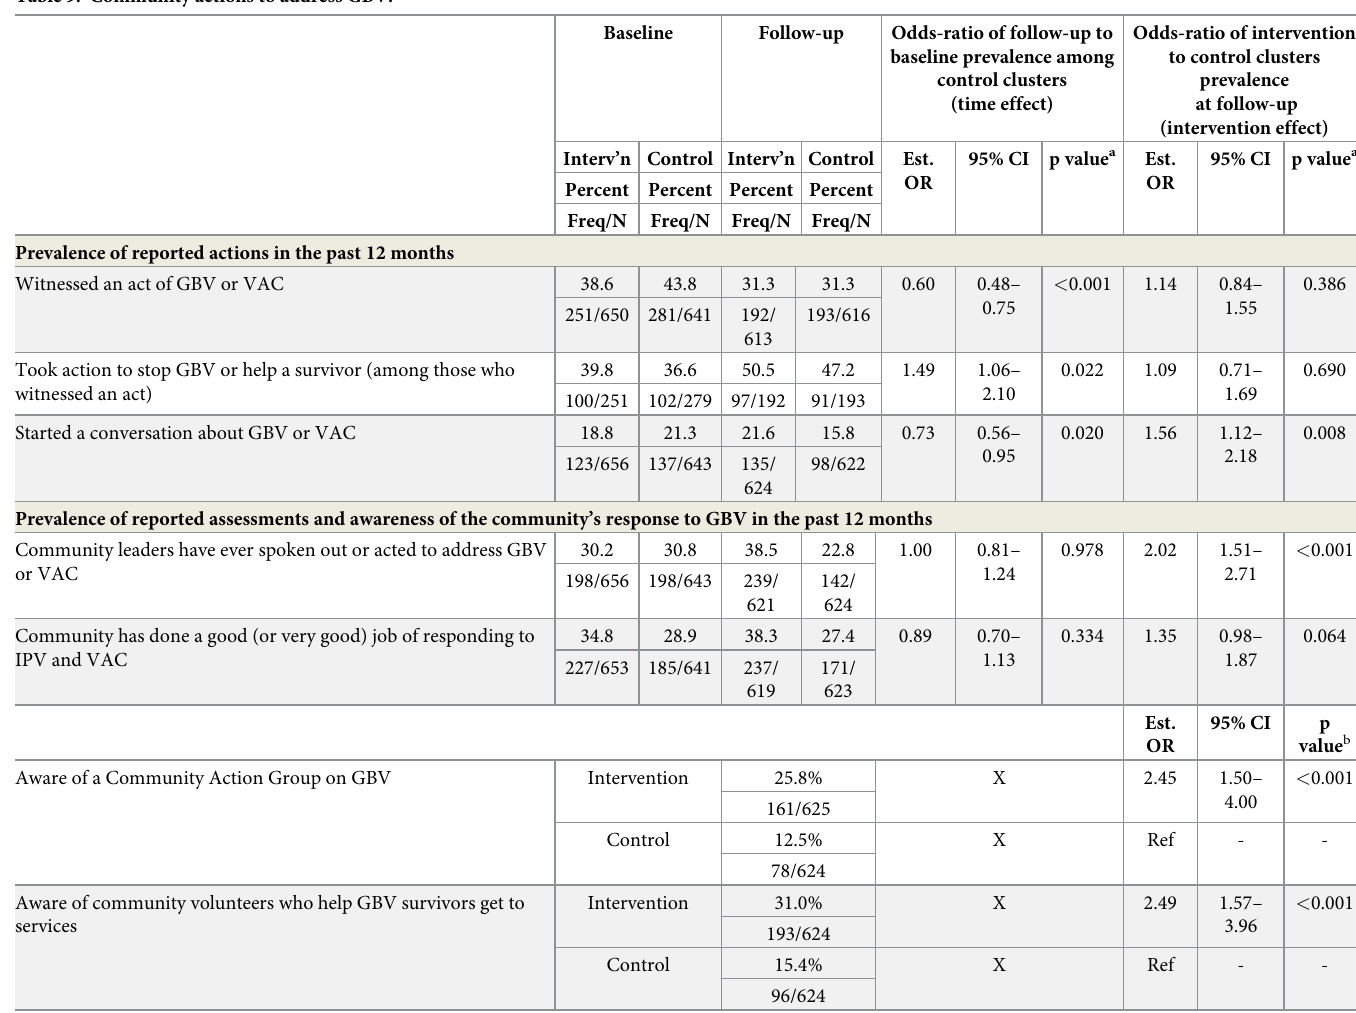
Table 9. Community actions to address